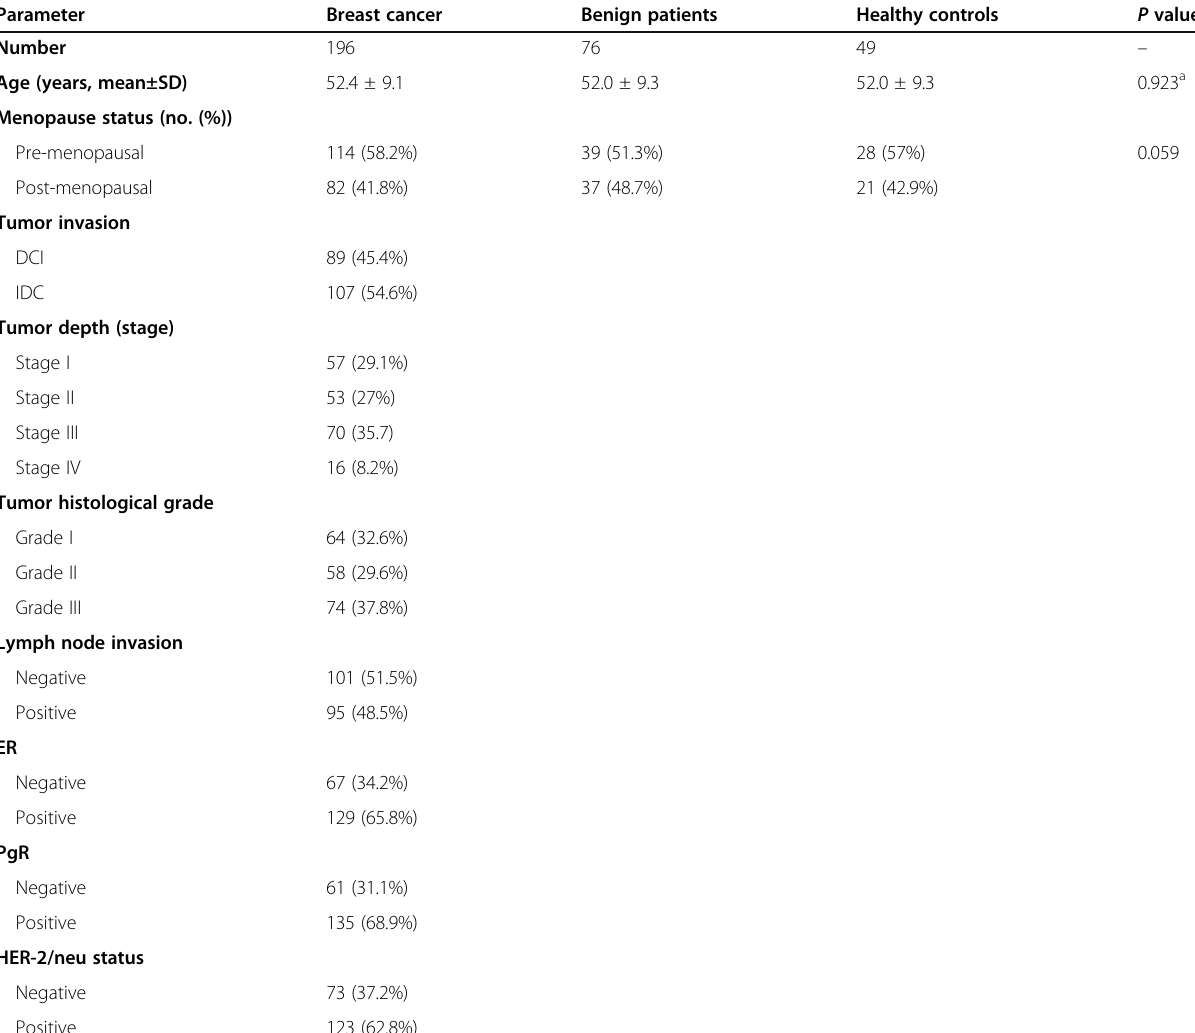
Table 1 Demographic and clinico-pathologic data of the investigated groups Parameter